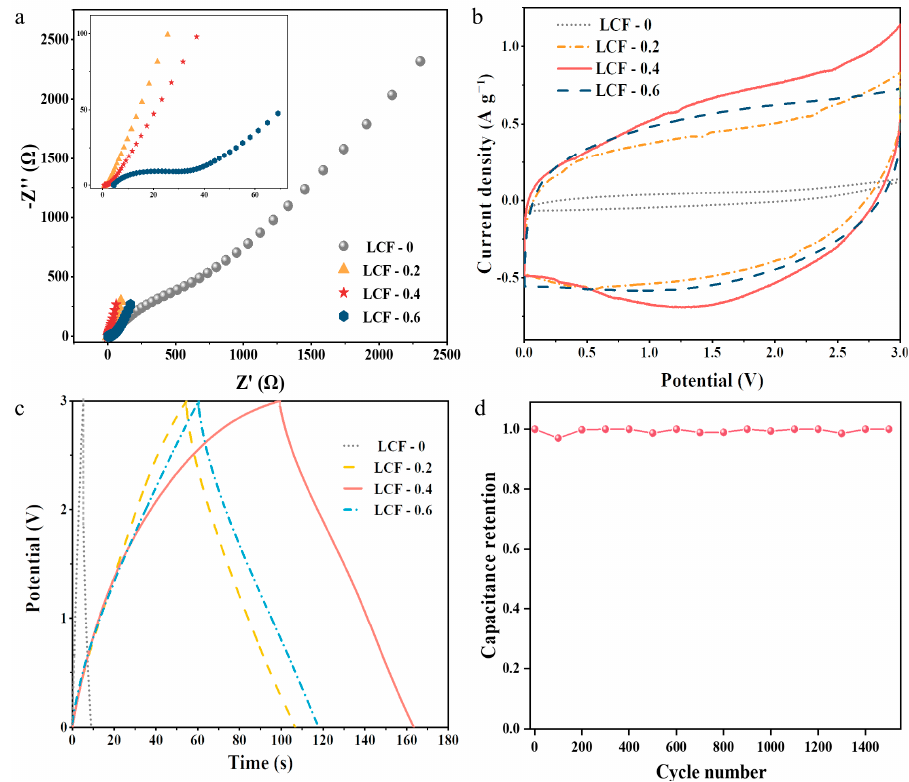
Figure 6. Electrochemical performance of the LCF-based supercapacitors. ( a ) Nyquist plots and ( b ) CV curves of the LCF electrodes at a scan rate of 0.05 V s − 1 . ( c ) GCD curves at a current density of 0.5 A g − 1 . ( d ) Capacitance retention at 1500 cycles. Table 4. Summarized supercapacitor performance using different LCF